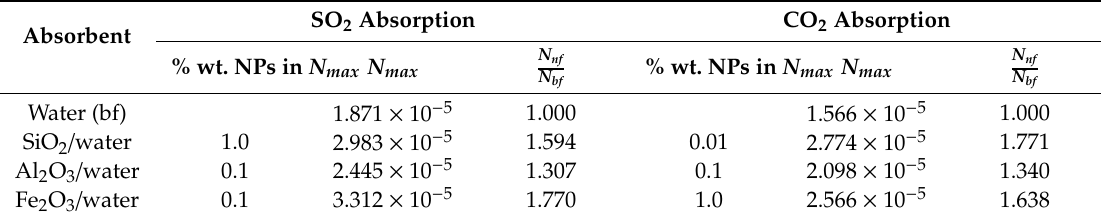
Figure 5. Average molar flux of CO 2 versus mass fraction of metal oxides nanoparticles (NPs). Table 2. Maximum molar flux and relative absorption rate for SO 2 and CO 2 .